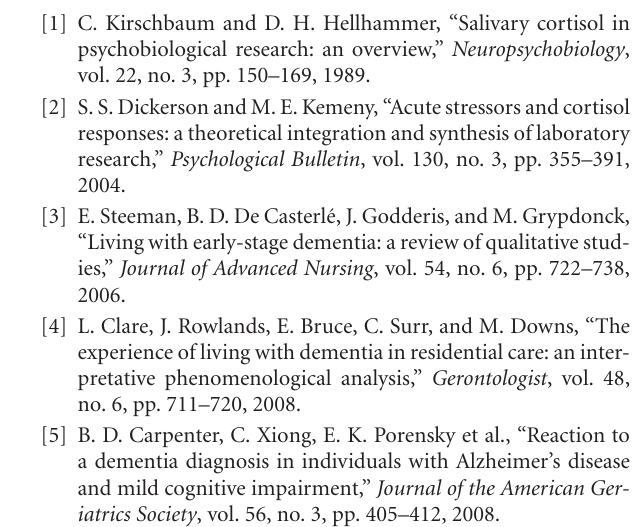
Table 1) were within the suggested normal range (mean: 12.0 ± standard deviation: